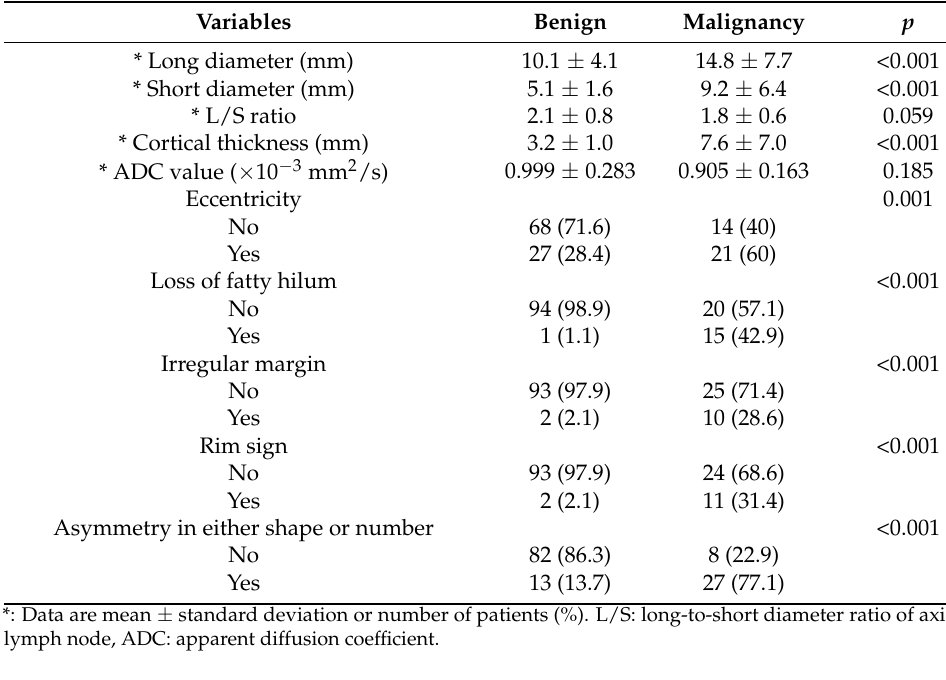
Table 3. DW-MRI characteristics of axillary lymph nodes.